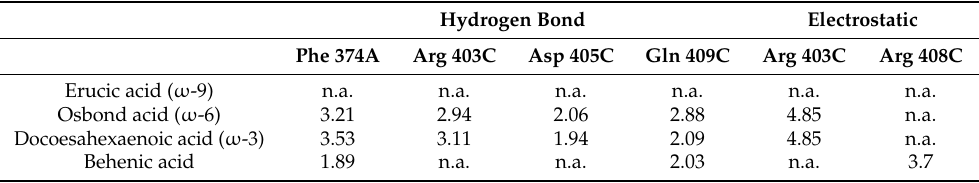
Figure 5. Predicted poses of the complex of ( a ) DHA (unsaturated, in yellow) and ( b ) behenic acid (saturated, in yellow) within the fatty acid-binding pocket of S-protein. Subunit A is colored in blue with the fatty acid binding pocket shown in white. Critical residues for anchoring the carboxylate group to subunit C (colored in green) are labeled. Table 4. Distance (Å) of the hydrogen bonds and electrostatic interactions from the carboxylate group in fatty acids with 22 carbon chains.